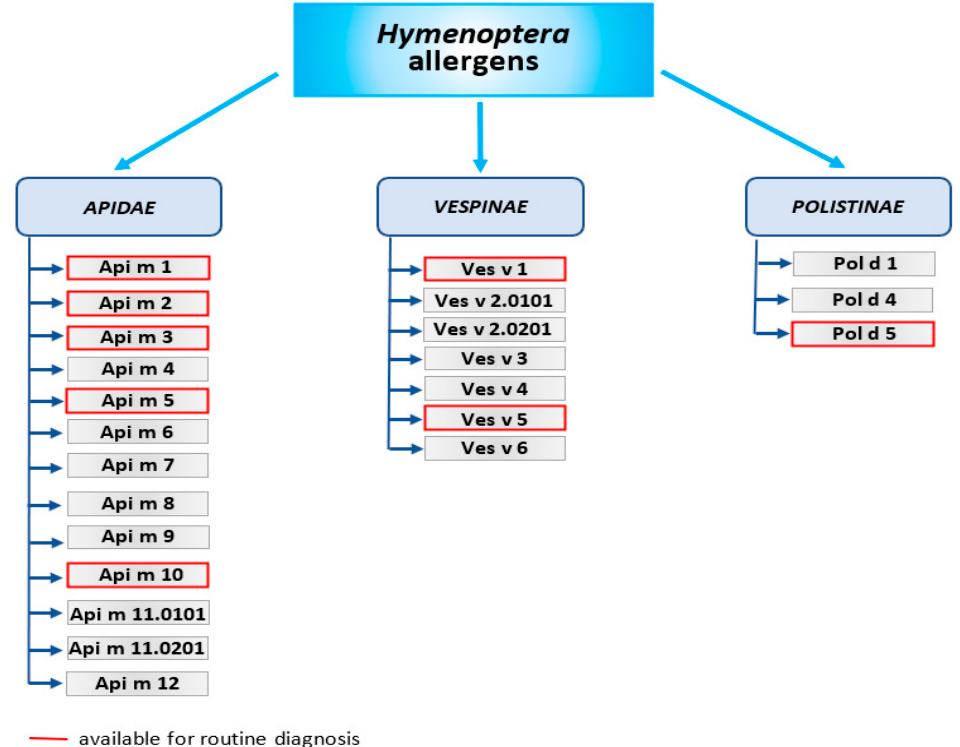
Figure 3. Allergens of Hymenoptera